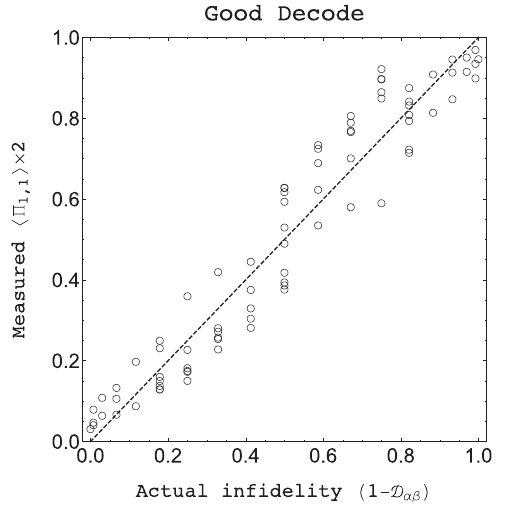
FIG. 17. Plot of measured versus actual infidelity between two states, given correct decryption. Dashed line indicates expected theoretical values.